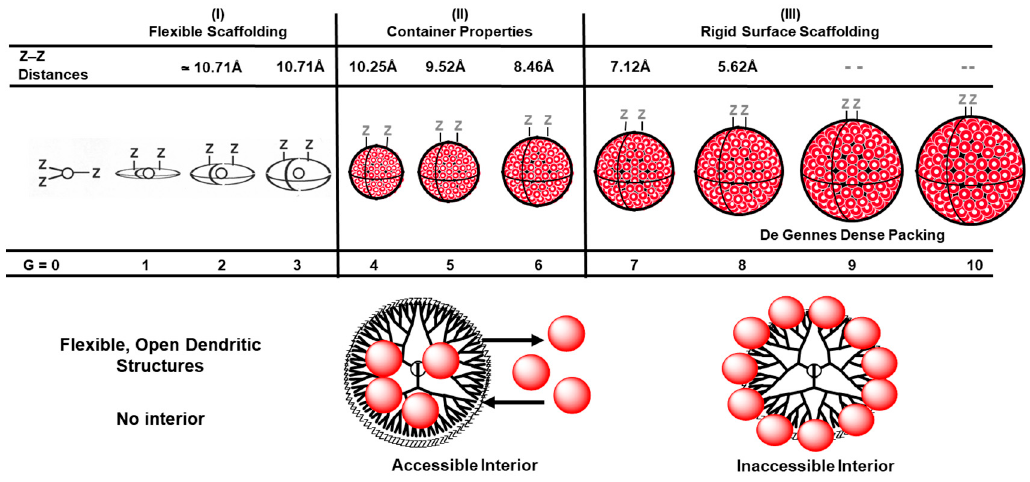
Figure 28. Congestion-induced dendrimer shape changes (I–III) with development of nanocontainer properties for a family of [core: 1,2-diaminoethane]; (4 → 2); dendri- poly(amidoamine)–(NH 2 ) Z };